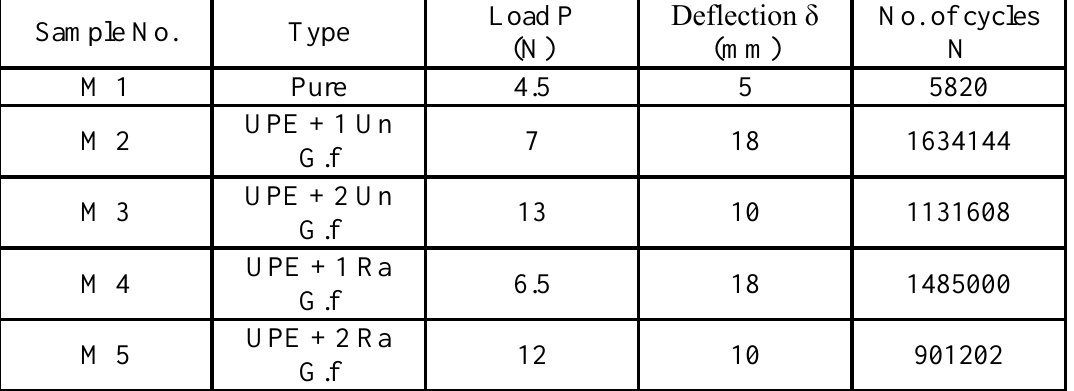
Table (4) : The load, deflection and the number of cycles for unsaturated polyester samples (un Reinforcing and reinforcing with glass fiber at volume fraction